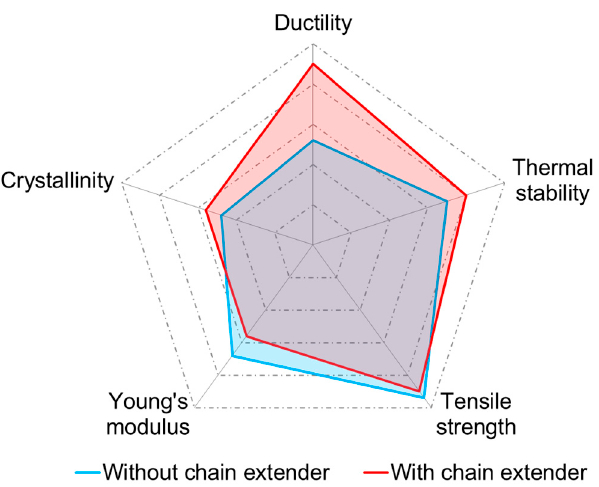
Figure 7. The performance comparison between the no-chain extender and 0.5% chain extender